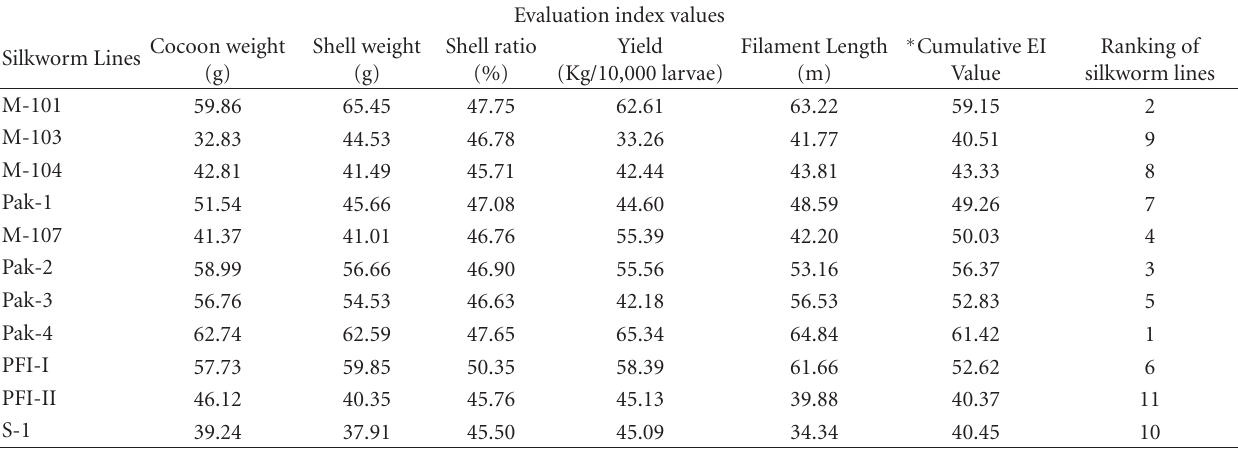
∗ The silkworm lines were ranked by establishing total cumulative